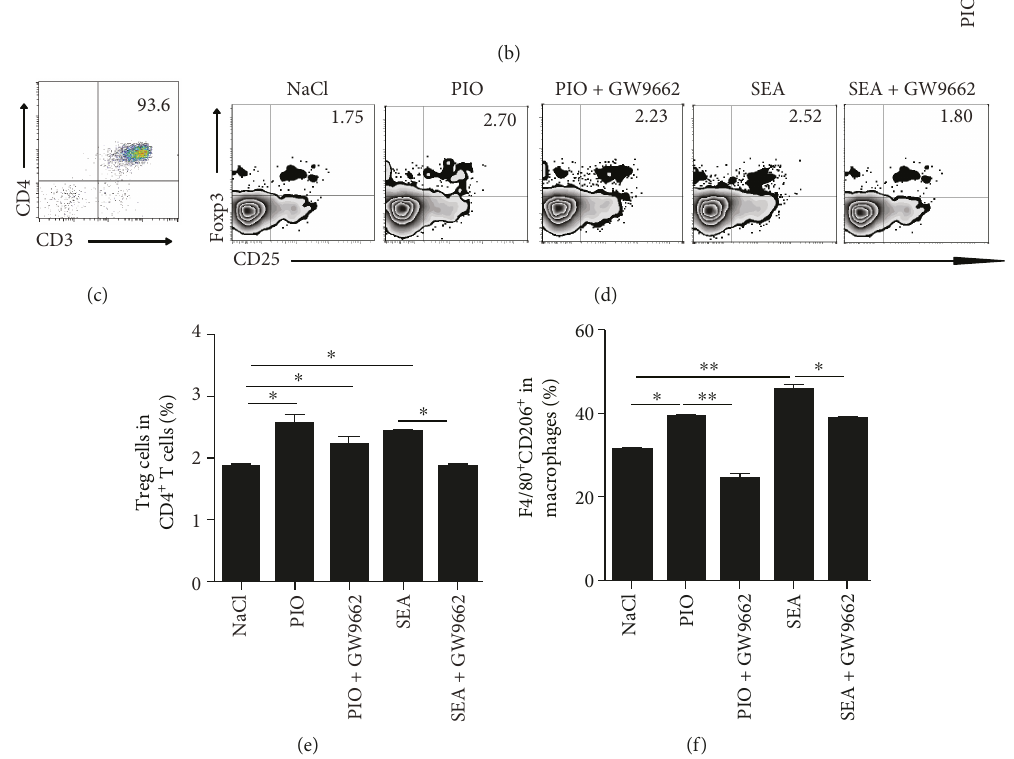
Figure 4: PPAR- γ signaling promotes Treg di ff erentiation involved in macrophages. (a, b) Peritoneal macrophages (1 × 10 6 ) were treated with pioglitazone (10 μ g/ml) with or without SEA (25 μ g/ml). The expression of CD80 + F4/80 + or MHCII + F4/80 + was evaluated by fl ow analysis. (c) CD4 + (CD3 + CD4 + ) T cells from normal mice were prepared by magnetic-activated cell sorting. Flow analysis results show that purity was ~ 94%. (d, e) Macrophages were treated with pioglitazone (10 μ g/ml) with or without SEA (25 μ g/ml) and cocultured with puri fi ed CD4 + T cells for 24 h, then Treg (CD4 + CD25 + Foxp3 + ) cells were analyzed by FACS. (f) After peritoneal macrophages (1 × 10 6 ) were treated with pioglitazone (10 μ g/ml) with or without SEA (25 μ g/ml), the percentage of M2 macrophages (CD206 + F4/80 + ) was evaluated by fl ow analysis. All experiments were repeated three times with similar results (ANOVA/LSD), ∗ P < 0 05 and ∗∗ P < 0 01